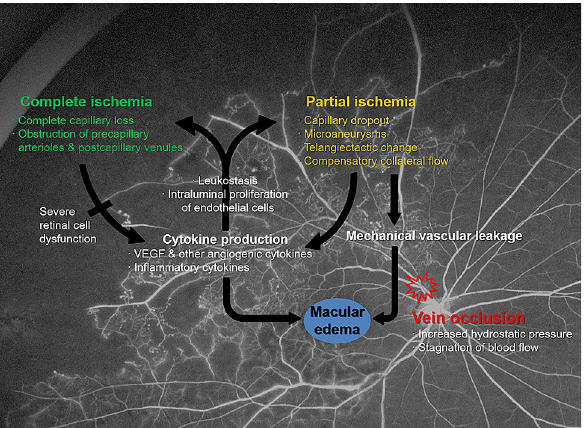
Figure 1. Schematic representation suggesting the relationship between retinal ischemia, cytokine production, and macular edema in patients with branch retinal vein occlusion. Vein occlusion is accompanied by increased hydrostatic pressure and blood flow stagnation, causing retinal ischemia, predominantly partial ischemia in peri-macular and near-peripheral region and complete ischemia in mid- and far-peripheral region. Partial ischemia may cause macular edema, in consequence of vascular hyperpermeability through increased cytokine secretion, such as VEGF, and direct leakage from damaged vessels. While, complete ischemia contributes less to cytokine production and direct leakage due to severe retinal cell dysfunction and loss of vessels. Increased cytokines can lead to complete ischemia progression through leukostasis and intraluminal proliferation of vascular endothelial cells within capillaries and